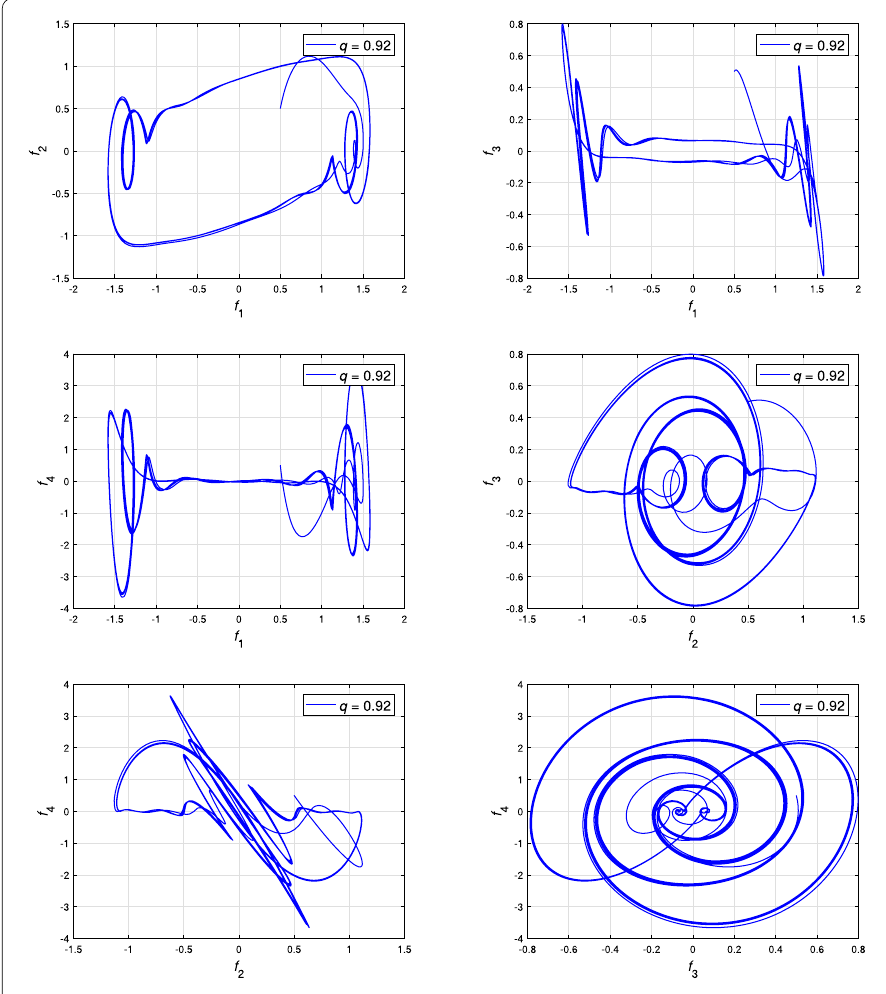
Figure 2 The phase planes of the fractional chaotic system (6) for q =